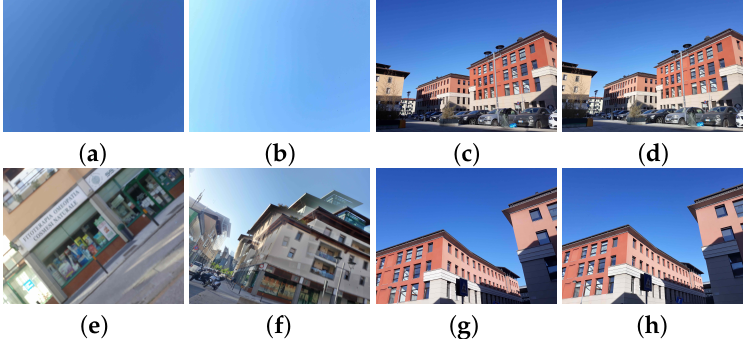
Figure 3. Sample pictures from the dataset: ( a ) FLAT SDR, ( b ) FLAT HDR, ( c ) Tripod SDR, ( d ) Tripod HDR, ( e ) Shaky hand SDR, ( f ) Shaky hand HDR, ( g ) Hand SDR and ( h ) Hand